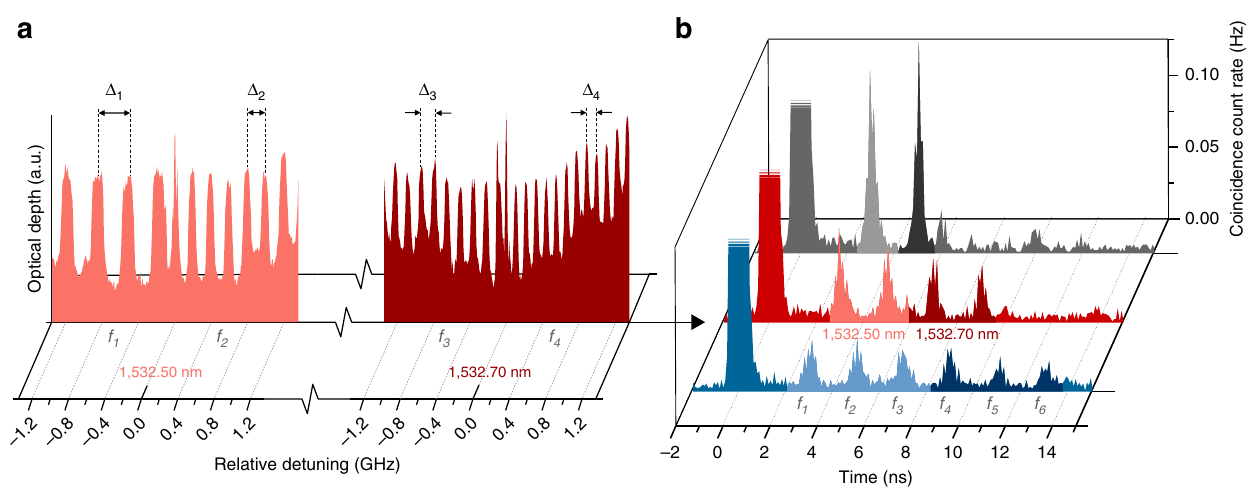
Figure 5 | Multimode quantum storage. ( a ) Creation of AFCs. The total, currently addressable bandwidth of 18GHz is divided into different spectral sections, each featuring an AFC with distinct peak spacing. Depicted is the case of four, 4.5-GHz-wide AFCs, created using two lasers operating at 1,532.50 and 1,532.70nm. The AFCs feature peak spacings of 333, 200, 143 and 111MHz, corresponding to storage times of 3, 5, 7 and 9ns, respectively. For each AFC, only a 1.3-GHz-wide section is shown. ( b ) Storage and recall. When broadband heralded photons with 50GHz bandwidth are mapped onto a two-section AFC, where each section extends over 9GHz bandwidth and has a peak spacing of 333 and 200MHz, respectively, they are stored in two spectral modes and retrieved in two spectro-temporal modes, as shown in the back trace. Decreasing the bandwidth per AFC allows increasing the number of AFCs (spectral modes), as demonstrated with the storage of four and six spectral modes in the middle and the front trace, respectively. The modes are labelled f i . For each mode, g ð 2 Þ is measured to be larger than 2 (see Table 1). si